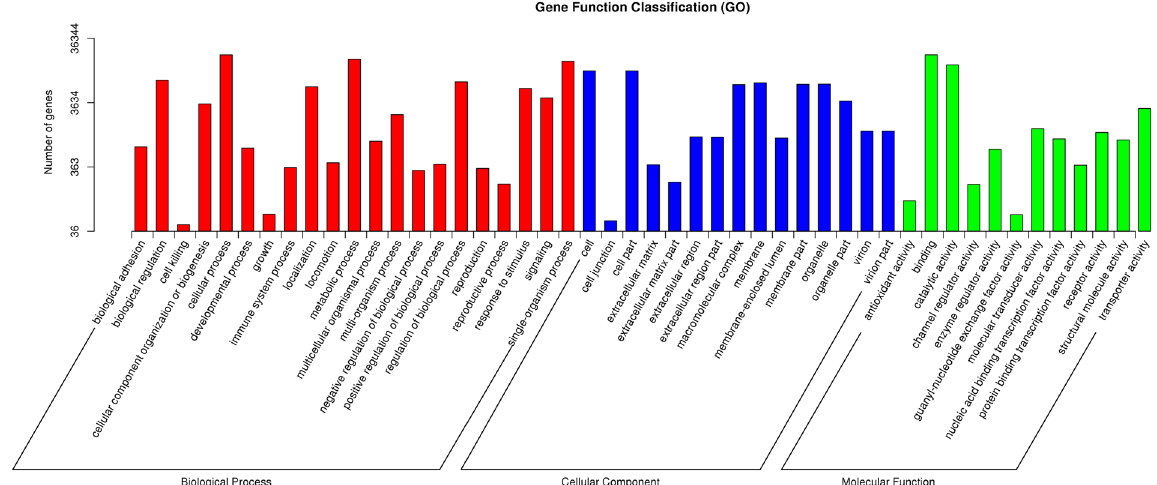
Figure 2. GO (Gene Ontology) categorization (biological process, cellular component, and molecular function) of the unigenes in the gill transcriptome of R. philippinarum . Each annotated sequence is assigned at least one GO term.